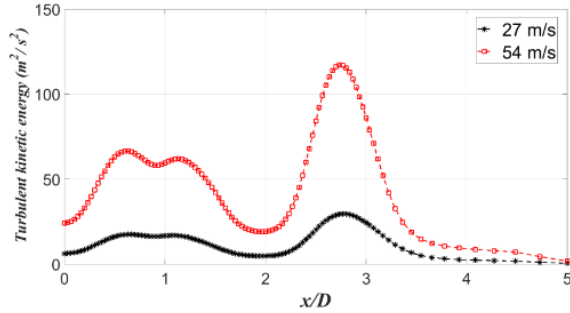
Figure 19. Turbulent kinetic energy distributions at different jet inlet velocities (z/D = 5).